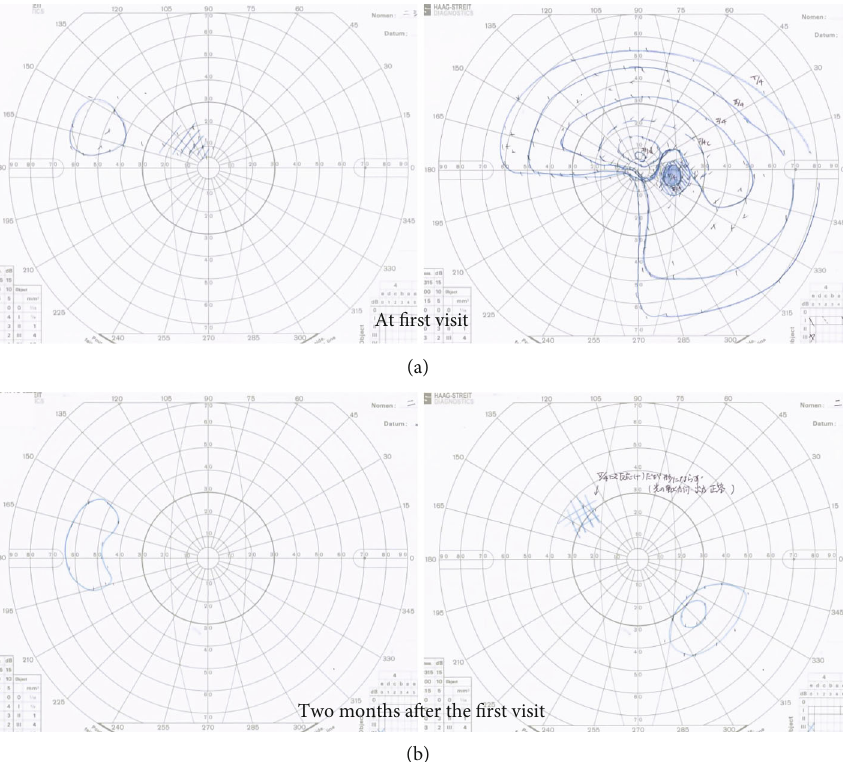
Figure 2: Visual fi elds. (a) At the fi rst visit, Goldman ’ s perimetry (GP) showed a visual- fi eld defect of the lower nasal right eye and extensive visual- fi eld loss in the left eye. (b) Two months after the fi rst visit, GP showed severe visual- fi eld defects with peripheral visual islands in both